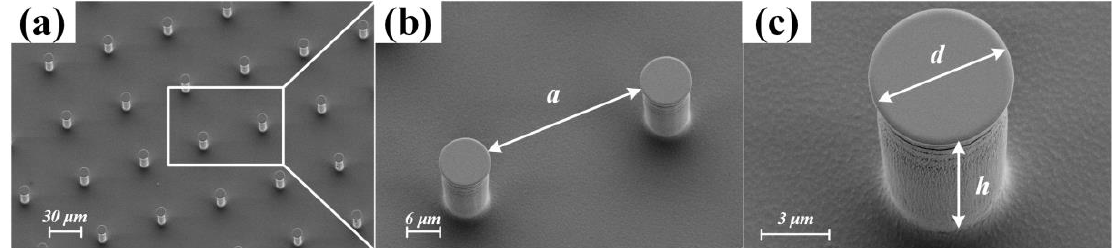
Figure 6. SEM pictures of SiO 2 rough surfaces. ( a ) The whole picture of the SiO 2 rough surface. ( b ) The periodic spacing a of the circular microstructures. ( c ) The diameter d and the height h of the circular microstructures.